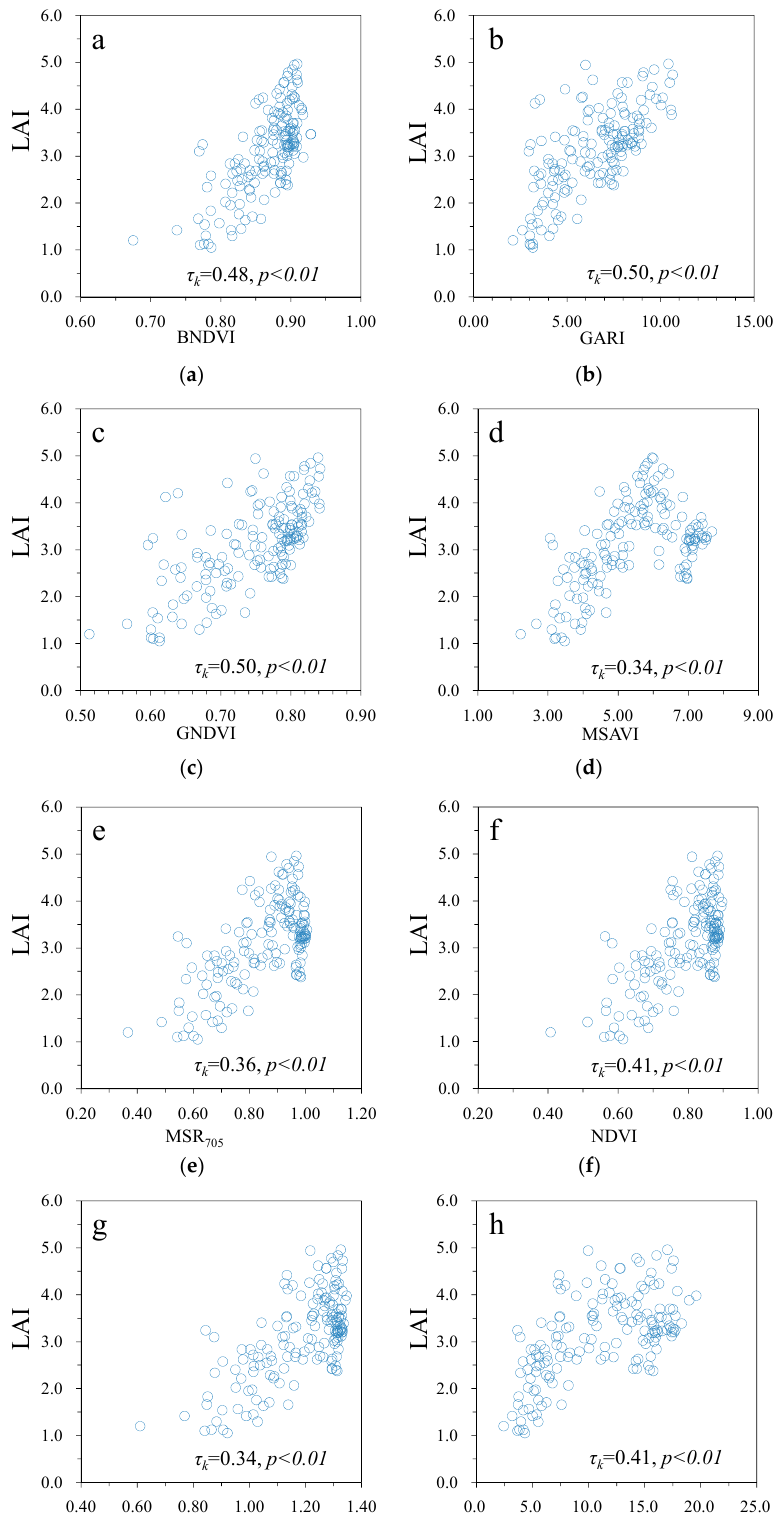
All the relationships for both empirical analysis and model simulations were significant ( p < 0.01).